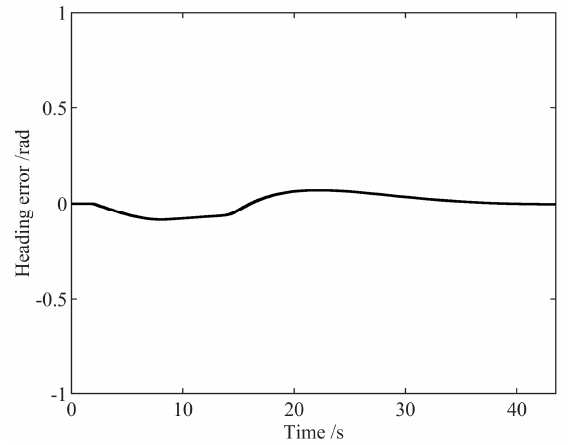
Figure 28. Heading error between the tractor and the reference path in the third group of simulations.